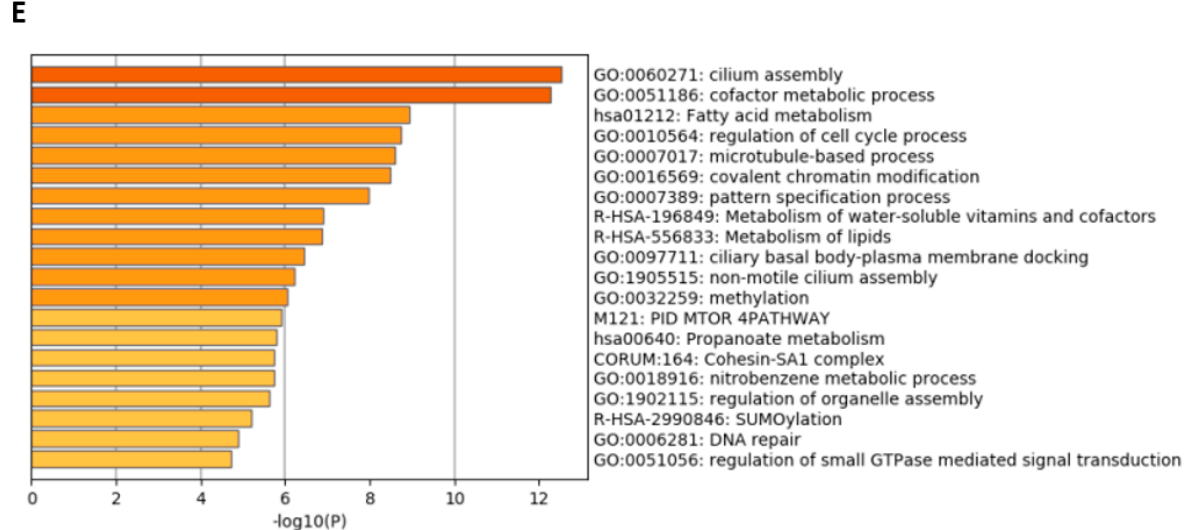
Figure 3. Comparative transcriptome and Gene Ontology analysis of urine-derived renal progenitors UF45, UM 48, UM51, and derived podocytes. A hierarchical cluster dendrogram revealed distinct clusters of UdRPCs and their derived podocytes. ( A ). Expressed genes (det- p < 0.05) in UdRPCs and podocytes compared in the Venn diagram ( B ) show distinct (600 in podocytes; 200 in UdRPCs) and overlapping (13,762) gene expression patterns. Of the overlapping genes, 671 are upregulated and 900 are downregulated in podocytes. The most over-represented GO-BP terms exclusive in either UdRPCs or podocytes are shown in ( C ) and include cell division and activation of the pre-replicative complex for the UdRPCs and cell fate commitment, cell morphogenesis, and regulation of ion transport for the podocytes. The upregulated 671 genes in podocytes, are associated with cell adhesion, positive regulation of cell migration, cell substrate adhesion, morphogenesis of an epithelium, and regulation of cytokine production ( D ), while downregulated 900 genes are associated with cell cycle processes and methylation ( E